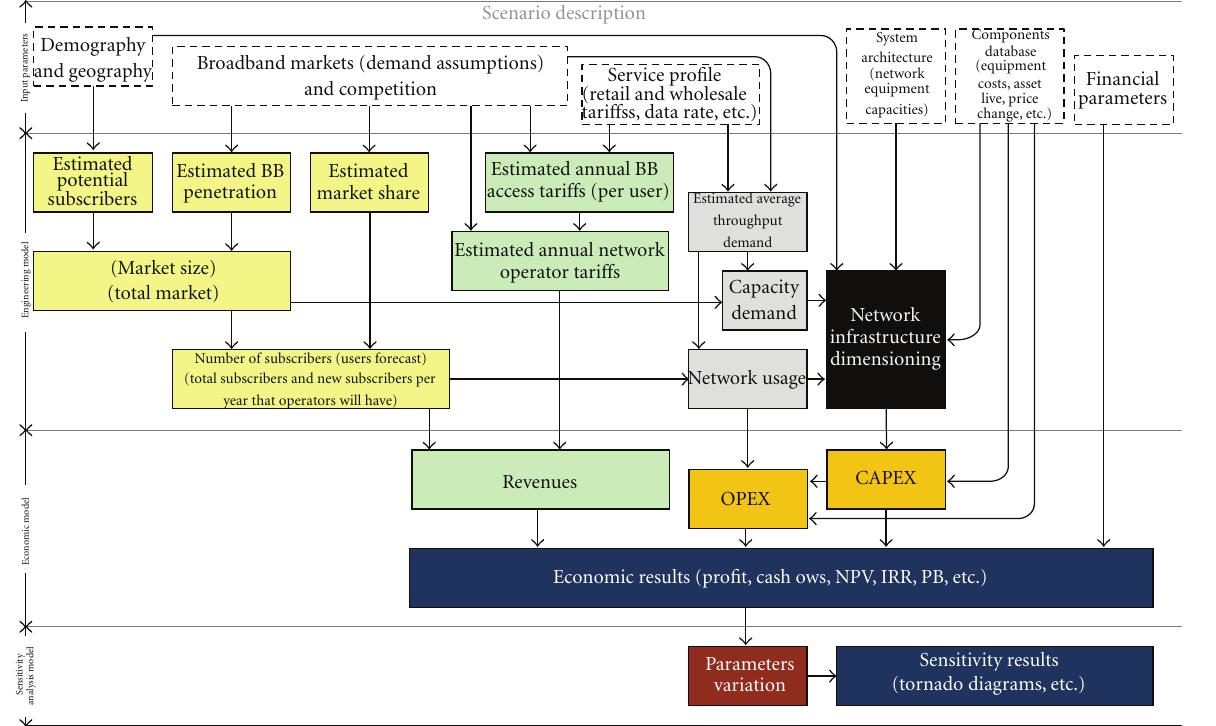
Figure 1: Model structure